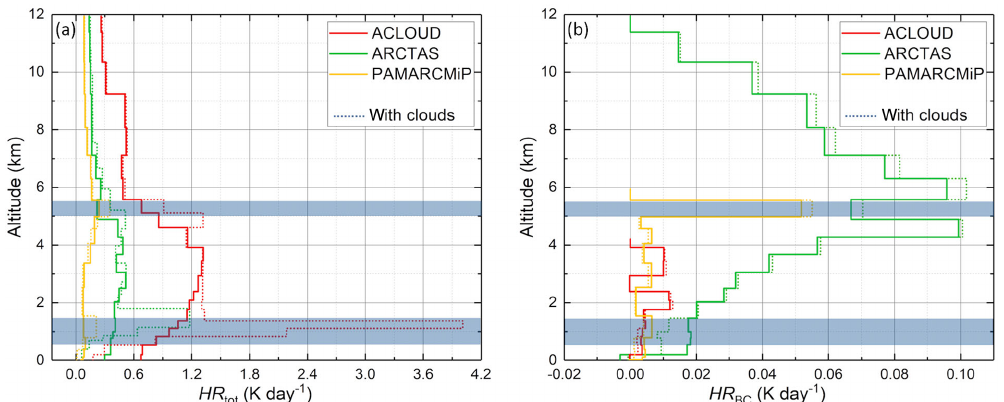
Figure 7. Daily averaged profiles of the total radiative heating rate HR tot (z) (a) and the effective BC heating rate HR BC (z) (b) calculated for the three cases ACLOUD, ARCTAS, and PAMARCMiP. Both cloudless simulations (solid lines) and cloudy scenarios (dotted lines) are shown. The gray shaded areas indicate the location of the cloud layers.